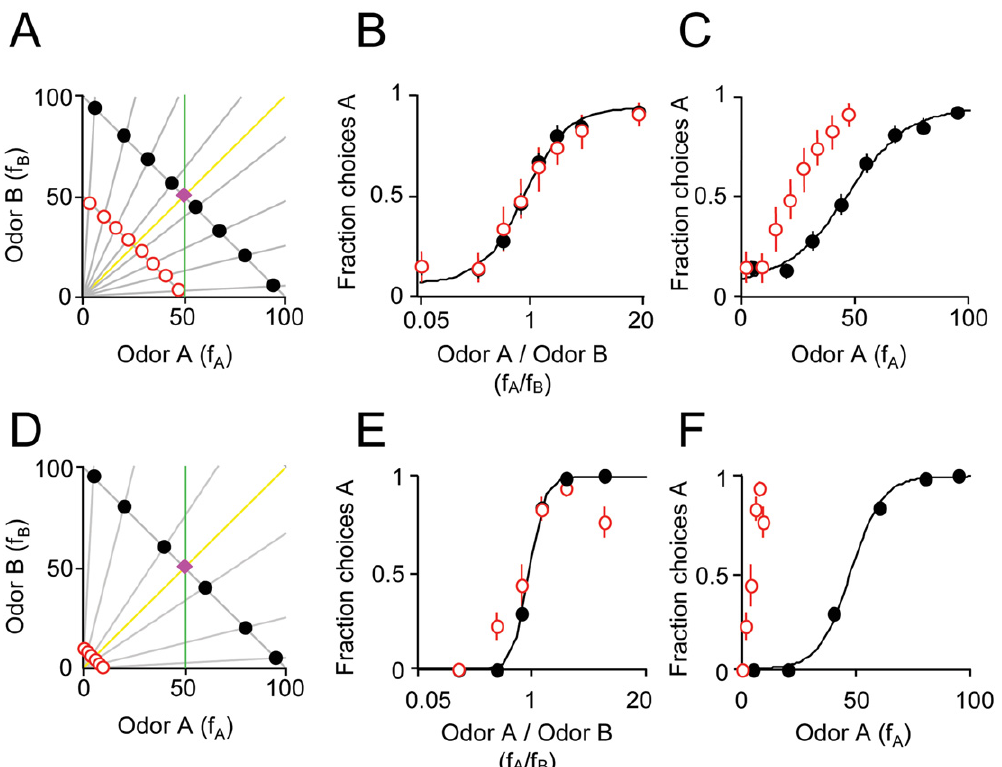
Figure 1. Odor mixture discrimination by rats respects the ratio of mixture components. (A) Stimuli were binary mixtures of two odorants (A, caproic and f , were varied by air fl ow dilution (100 = 60 ml/min of saturated vapor diluted in 1,000 ml/min clean air, see acid; B, 1-hexanol) whose magnitudes, f A B Materials and methods section). Training stimuli (black fi lled circles) were rewarded according to the dominant component. The reward boundary is indicated by + f = 100. Test stimuli (red circles) were randomly rewarded ( p = 0.5). Note that test the magenta diamond. Note that training stimuli were chosen such that f A B + f = 50. Note that training and test stimuli were chosen with the same component ratios (as indicated by the gray lines). The stimuli were chosen to have f A B = 1) represents stimulus classifi cation based on ratio of two mixture components. The green line ( f = 50) represents a classifi cation boundary / f yellow line ( f A B A based on one component (A). Note that yellow and green lines both correctly classify the training stimuli but result in different classifi cations of the test stimuli. / f and the (B) Performance of one rat on training odors (black fi lled circles) and probes (red circles). The abscissa is the ratio of the odor mixture components, f A B ordinate is the fraction of choices for the port associated with odor A. A sigmoid function was fi tted to the choices of the rat on training stimuli (see Materials and methods section) using the odor mixture ratio as the independent variable. Error bars show ± 1 SEM (see Materials and methods section). Some training data points are not visible because they are hidden behind the corresponding test data points. Note that the sigmoid also fi ts the test stimuli even they were not ) as the independent variable. The fi t is also performed using used in the fi tting procedure. (C) The same data as (B) plotted using the magnitude of odor A ( f A the magnitude of component A as the independent variable. Note that the fi tted function does not accurately predict the probe responses. (D) Experiment with + f = 100. Test stimuli (red circles) were chosen such that f + f = 10. Note that in this 1/10 dilution probe stimuli. Training stimuli (black fi lled circles) had f A B A B experiment, dilution was achieved by liquid rather than air dilution. (E) Performance of one rat on training odors (black fi lled circles) and 1/10 dilution probes / f . (F) Choices of one rat on training and 1/10 dilution probe stimuli. The independent variable is the single (red circles). The independent variable is the ratio f A B component